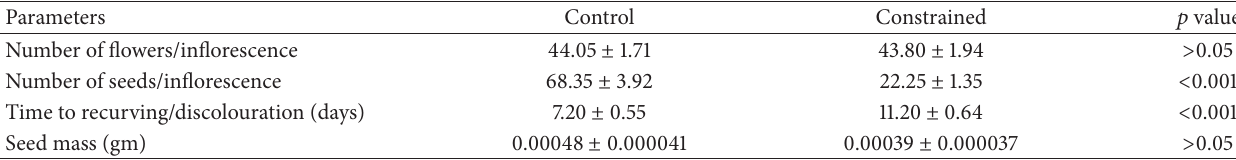
Table 1: Comparative account of the recorded parameters between the control and constrained plants ( 𝑛 = 20 , each).